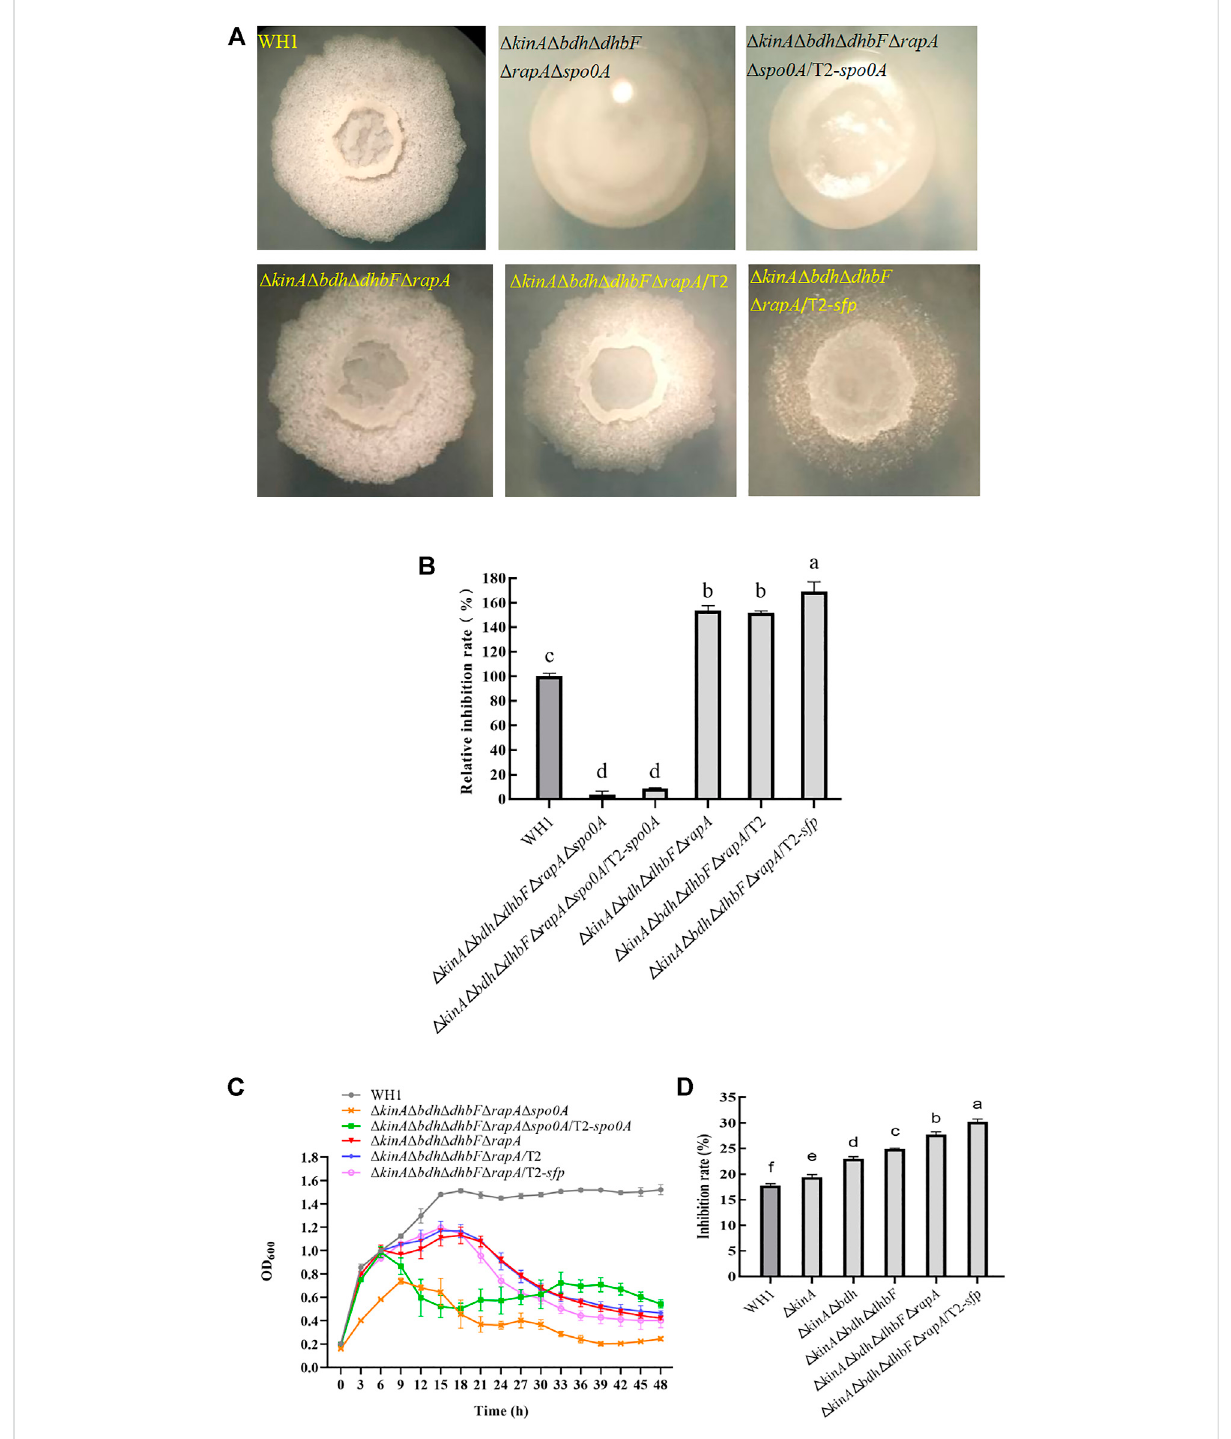
FIGURE 10 Relative inhibition rates and characteristics of Δ kinA Δ bdh Δ dhbF Δ rapA /T2- sfp . (A) : Colony morphology; (B) : Relative inhibition rates; (C) : Growth curves; (D) : Comparison of antifungal activity among different engineered strains (from the original strain WH1 to the fi nal strain Δ kinA Δ bdh Δ dhbF Δ rapA /T2- sfp